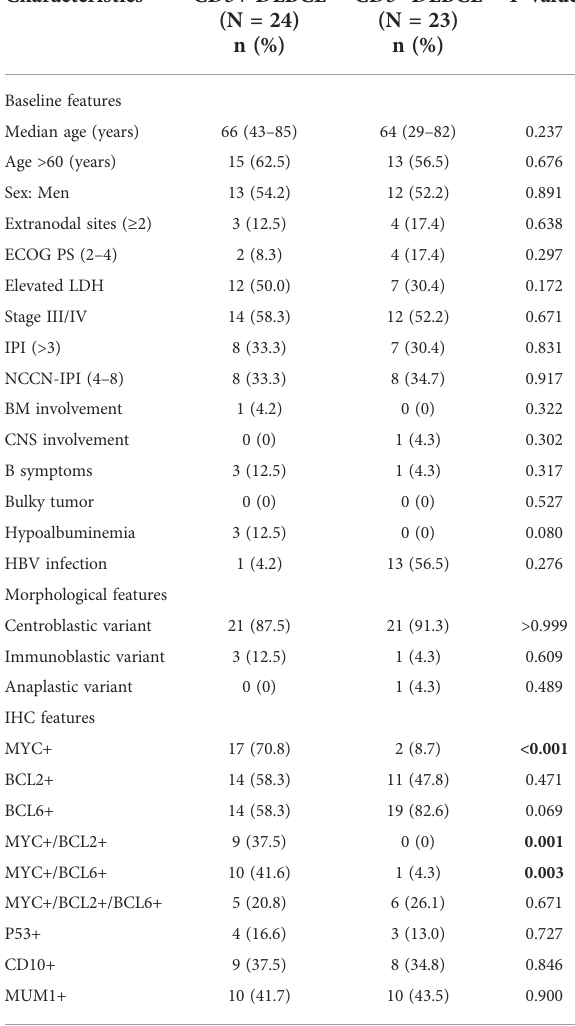
TABLE 1 Comparison of the baseline features and IHC results between CD5+ and CD5- DLBCL.